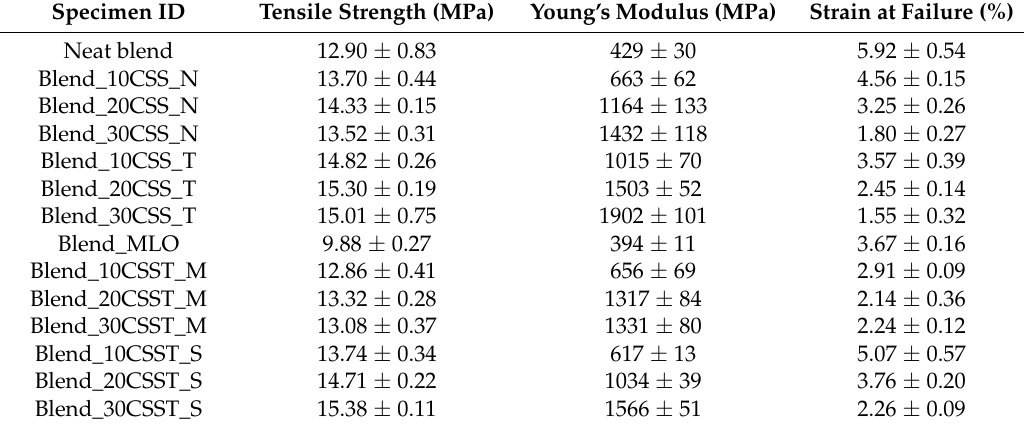
Table 2. Summary of tensile properties for PBAT/PHBV-based composites.